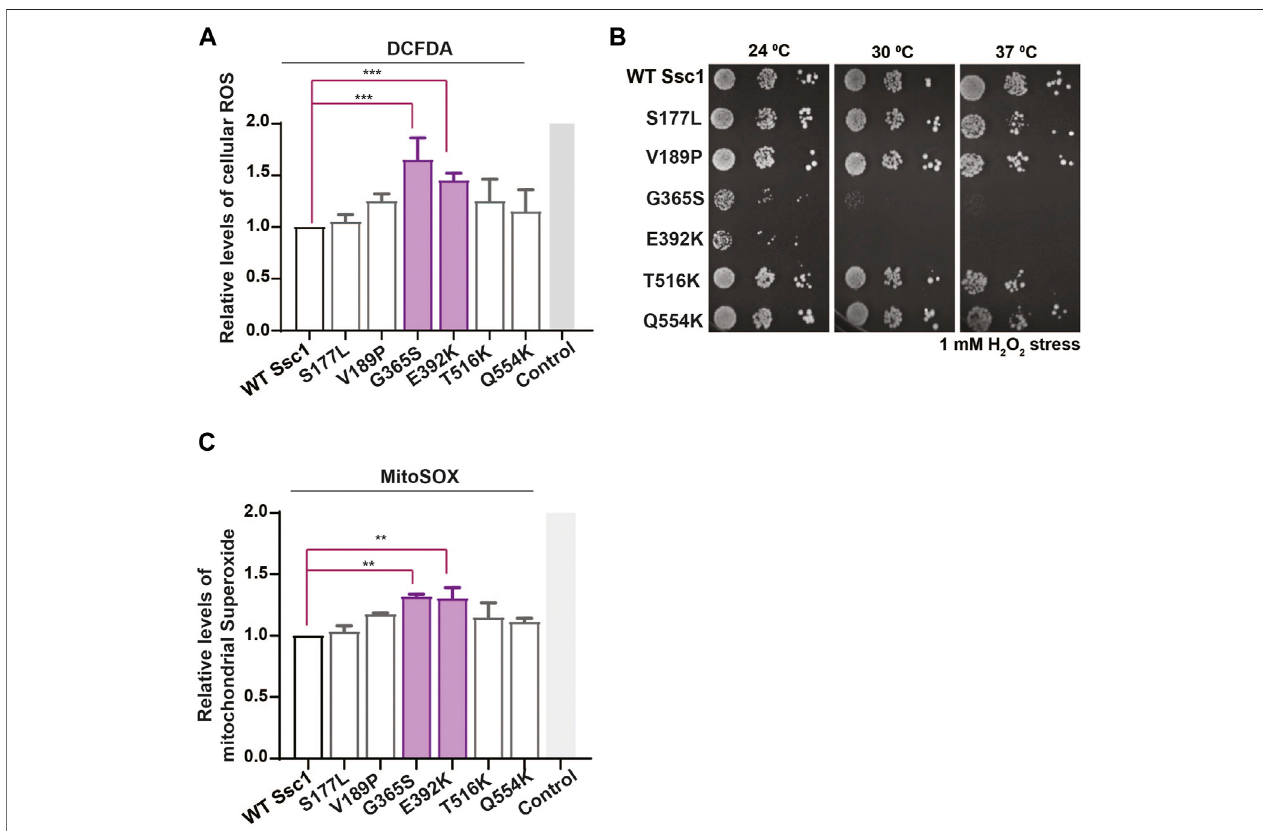
FIGURE 4 | Mutations in Ssc1 alter the redox balance and increase oxidative sensitivity. (A) Analysis of cellular ROS. Equivalent cells were stained with 100 µm